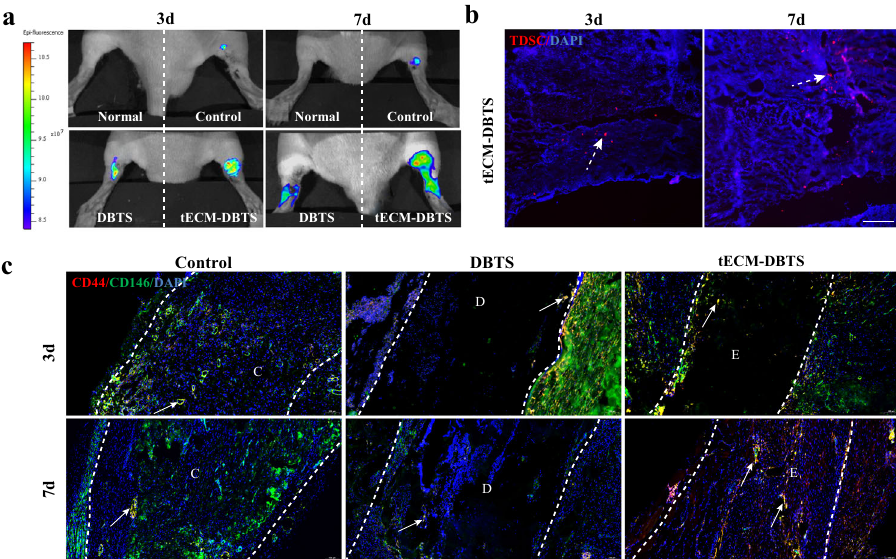
Fig. 4 The ability of the tECM-DBTS to recruit exogenous or endogenous stem cells in vivo. a In-vivo tracking of tail vein injection PKH67- labeled exogenous TDSCs using IVIS analysis at 3 days and 7 days. Normal: normal tendon, Control: autologous tendon repair. b Fluorescent image of the TDSCs (red) existed at the Achilles tendon healing site of the tECM-DBTS at 3 days and 7 days. White dashed arrows indicate PKH67-labeled TDSCs. c Immuno fl uorescent staining of CD44 (red immuno fl uorescence), CD146 (green immuno fl uorescence), and DAPI (blue immuno fl uorescence) in the control, DBTS and tECM-DBTS groups at 3 days and 7 days. The white dashed lines indicate the interface between the scaffold and host tissues. White arrows indicate recruited stem cells. C: autogenous tendon repair; D: DBTS; E: tECM-DBTS. Scale bars, b: 200 μ m; c: 100 μ